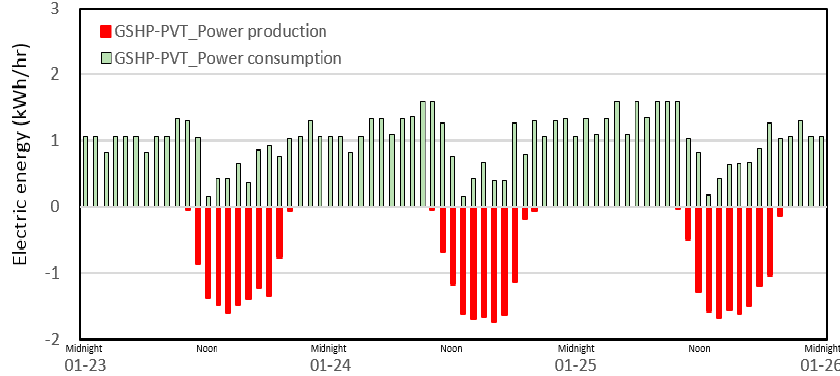
Figure 19. The electric energy of the Geo-PVT system in representing day.